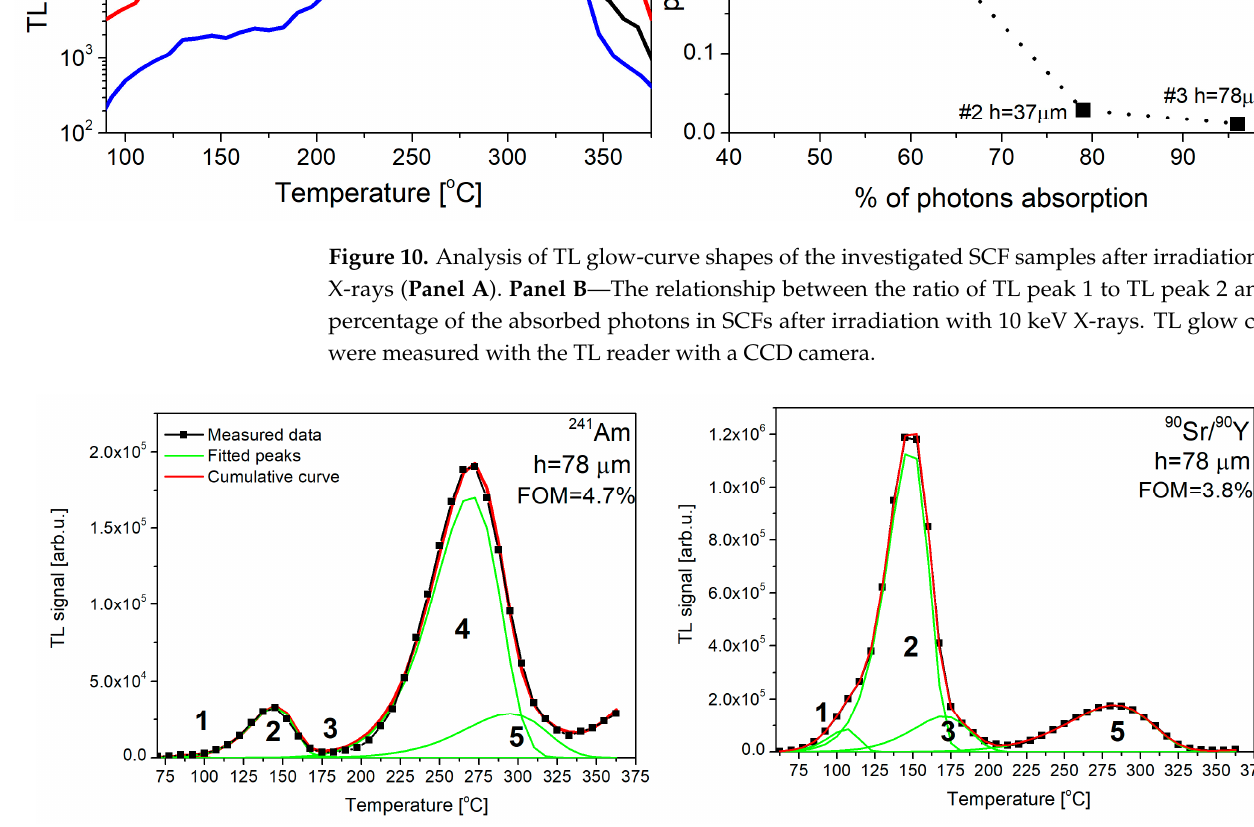
Figure 11. Exemplary results of the deconvolution performed for the studied LuAG:Ce SCF/YAG SC (h = 78 μ m) after irradiation with different types of ionizing radiation. Table 3. Peak parameter estimations using TL glow deconvolution.